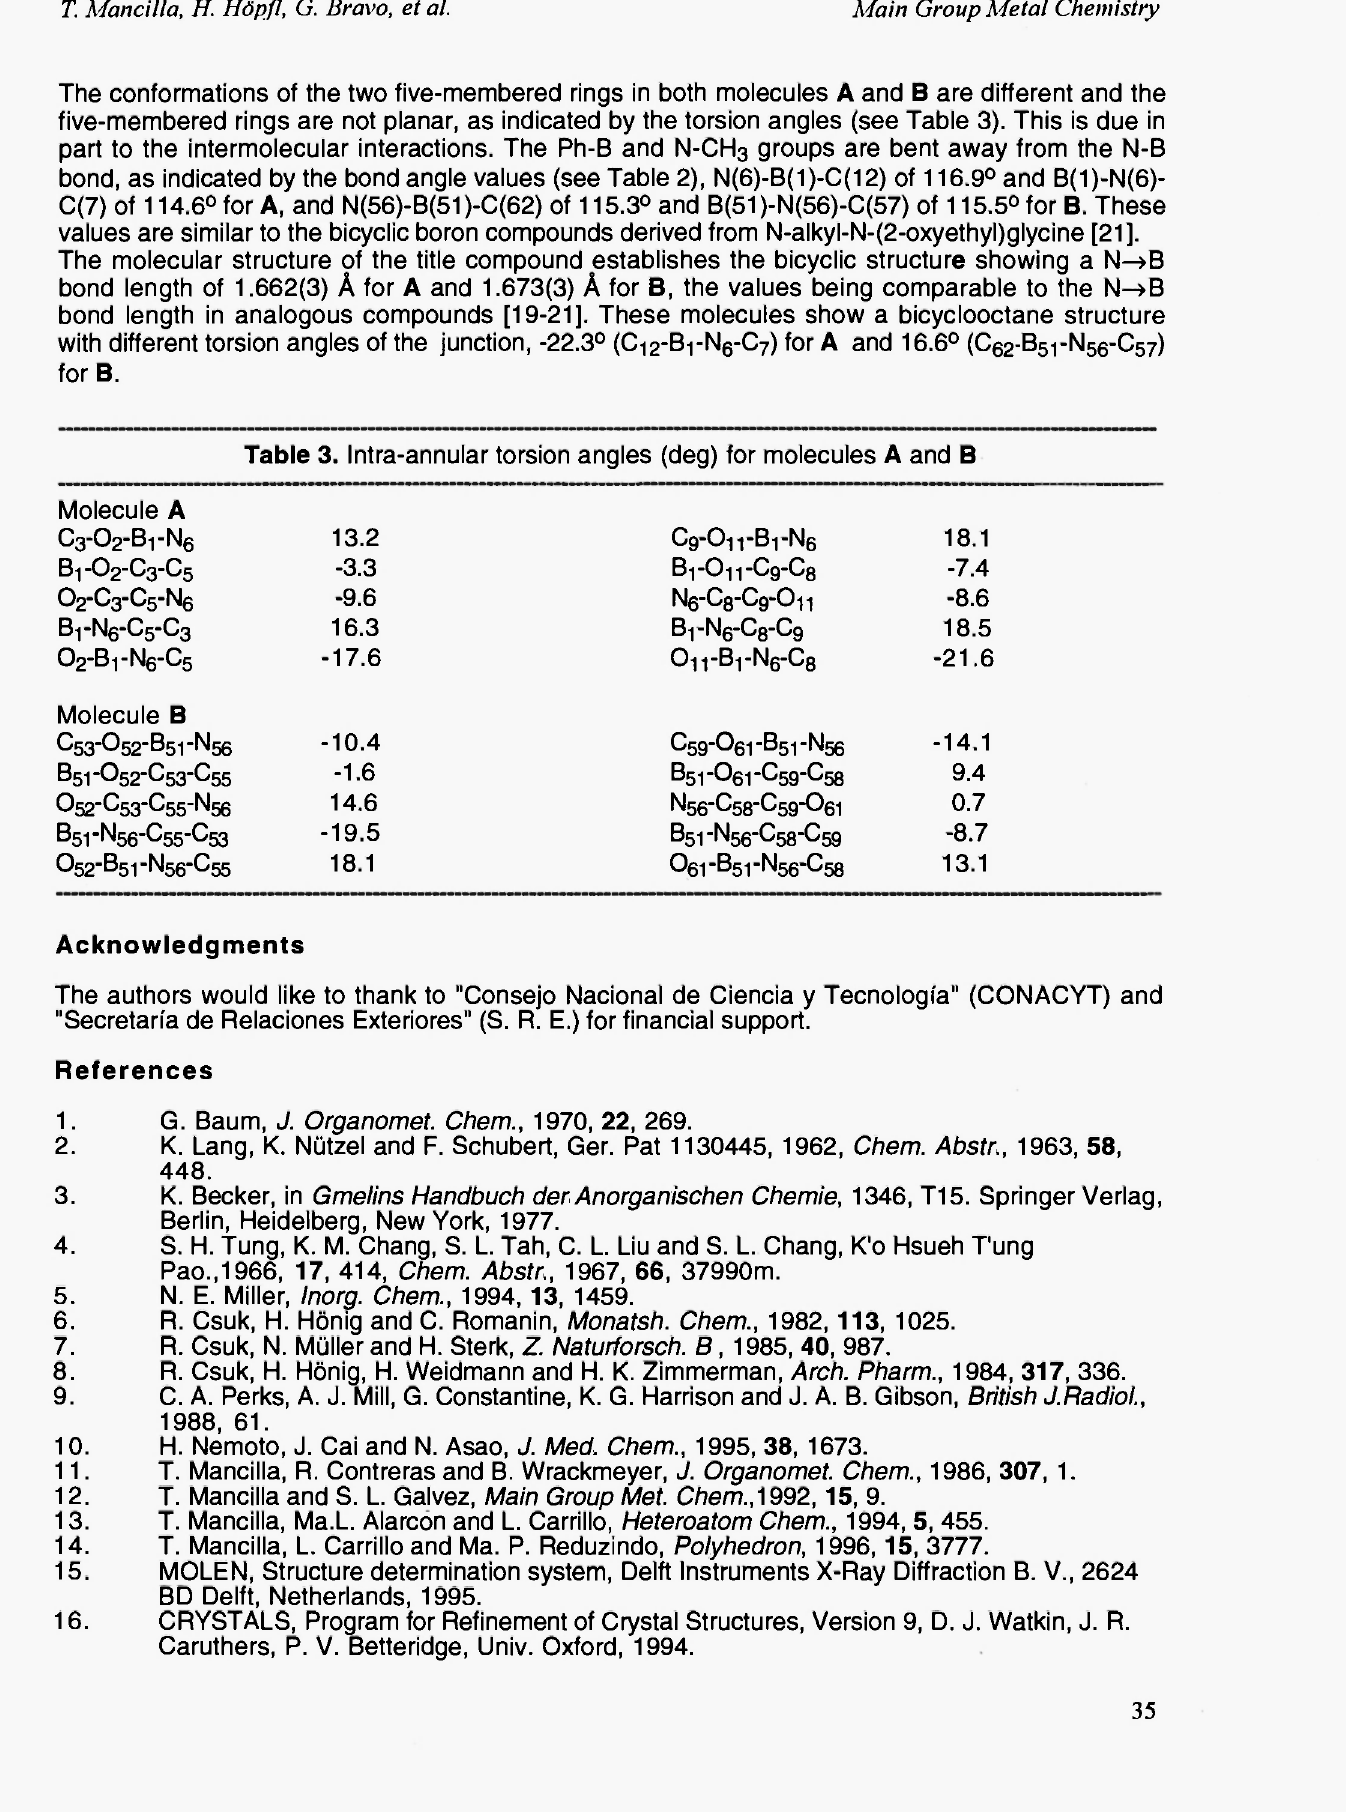
Table 3. Intra-annular torsion angles (deg) for molecules A and